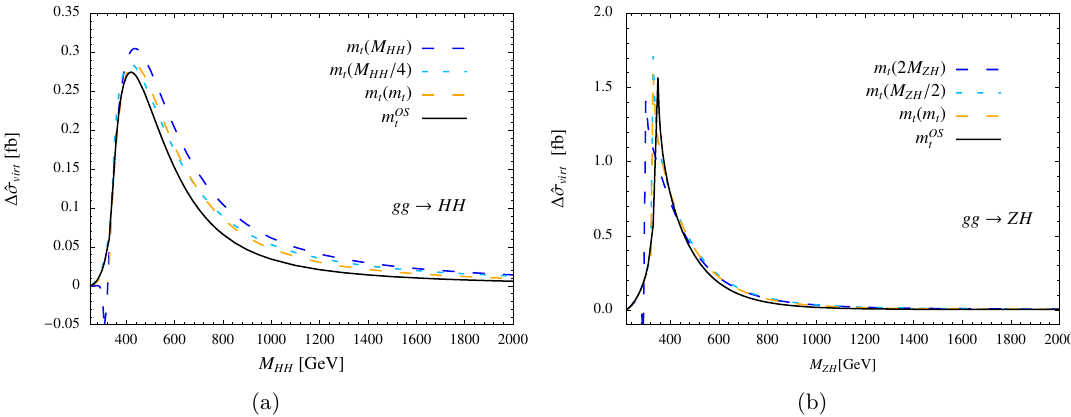
Figure 5. The integrated virtual corrections in different renormalisation schemes for the top quark mass for (a) gg → HH and (b) gg → ZH . The dashed lines show ∆ˆ σ virt in the MS scheme using the top quark mass evaluated at different choices of the renormalisation scale, while the black solid line shows the on-shell